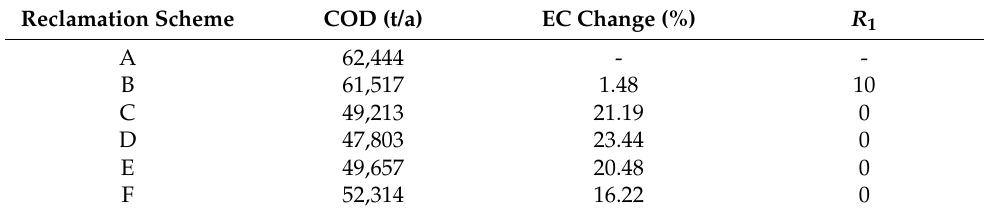
Table 5. Feasibility assessment in COD environmental capacity.